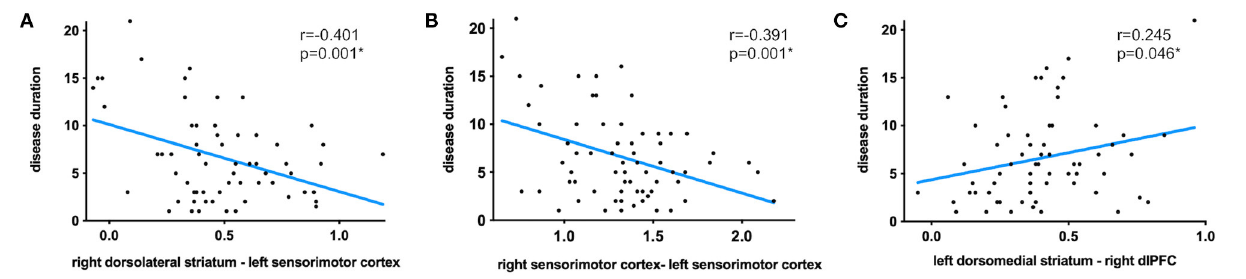
left dorsomedial striatum-right dlPFC pair ( Figure 3C : r = 0.245; p = 0.046). The MDS-UPDRS III scores were